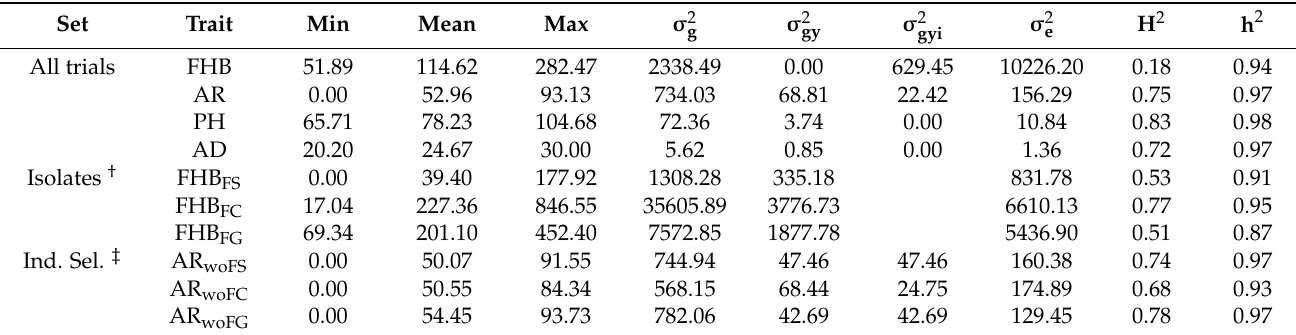
Table 2. Mean, range, variance components, and heritability for Fusarium head blight (FHB) severity (AUDPC), anther retention (AR) (%), plant height (PH) (cm), and anthesis date (AD) (days after May 1st) for the phenotypic analyses across all trials, trials inoculated with one of the F. sporotrichioides , F. culmorum , and F. graminearum isolates, respectively, as well as excluding one of these trial series at a time.